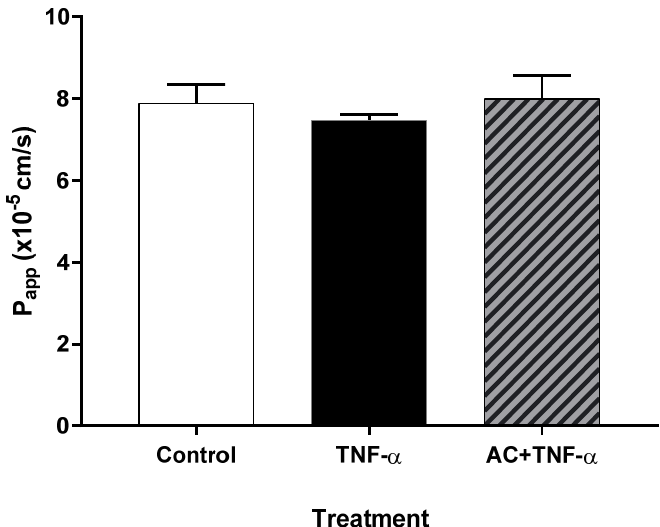
Figure 2. Apparent permeability coefficients (Papp) on HUVEC. Human umbilical vein endothelial cells (HUVECs) were pre-treated with TNF- α (10 ng/mL) and 85 µM AC + TNF- α (10 ng/mL) 24 h before permeability assay was performed. Permeability values were not significantly different; analysed by ANOVA.